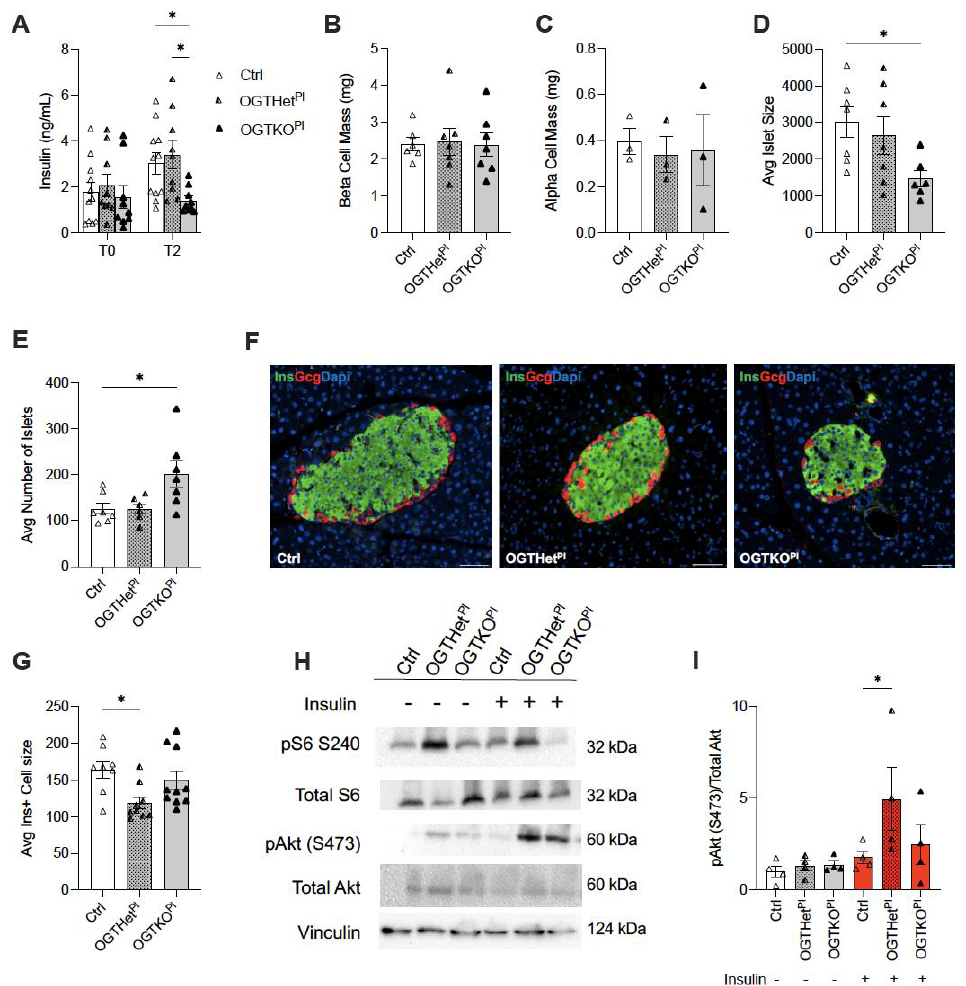
Figure 5. Increased pS473 (pAKT) in the liver of OGTHet Pl mice in response to insulin treatment after 12 weeks HFD. ( A ) In vivo glucose stimulated insulin secretion (GSIS) for females (n = 9, 11). T0 is a fasted state. T2 is two minutes post insulin injection. ( B ) beta cell mass in females after 12 weeks on HFD (n = 7). ( C ) α cell mass in females after 12 weeks on HFD (n = 3). ( D ) Average islet size for females after 12 weeks on HFD (n = 7). ( E ) Average number of islets for females after 12 weeks on HFD (n = 7). ( F ) Representative islets from each female genotype post HFD for 12 weeks with insulin (green), glucagon (red), and DAPI (blue) immunostaining. Magnification 20 × , scale bars 50 µ m. ( G ) Average islet cell size for females after 12 weeks on HFD (n = 8, 10). ( H ) Western blot for pAKT (pS473), total Akt, pS6 (S240), and total S6 in the liver following injection of insulin or injection of PBS as a control. Samples were taken from females on 12 weeks HFD (n = 4). ( I ) Quantification of western blot for pAKT (pS473)/total Akt from liver samples visualized in ( G ). ( A ) was presented as mean ± SEM, two-way ANOVA. ( B – E , G , I ) were presented as mean ± SEM, one-way ANOVA. p values, * p <